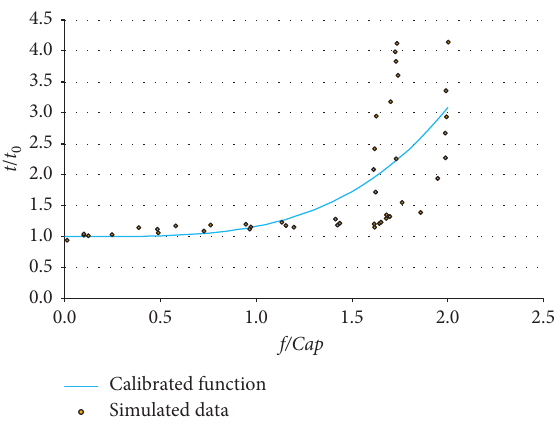
Figure 11: Calibrated BPR function for the integrated solution.